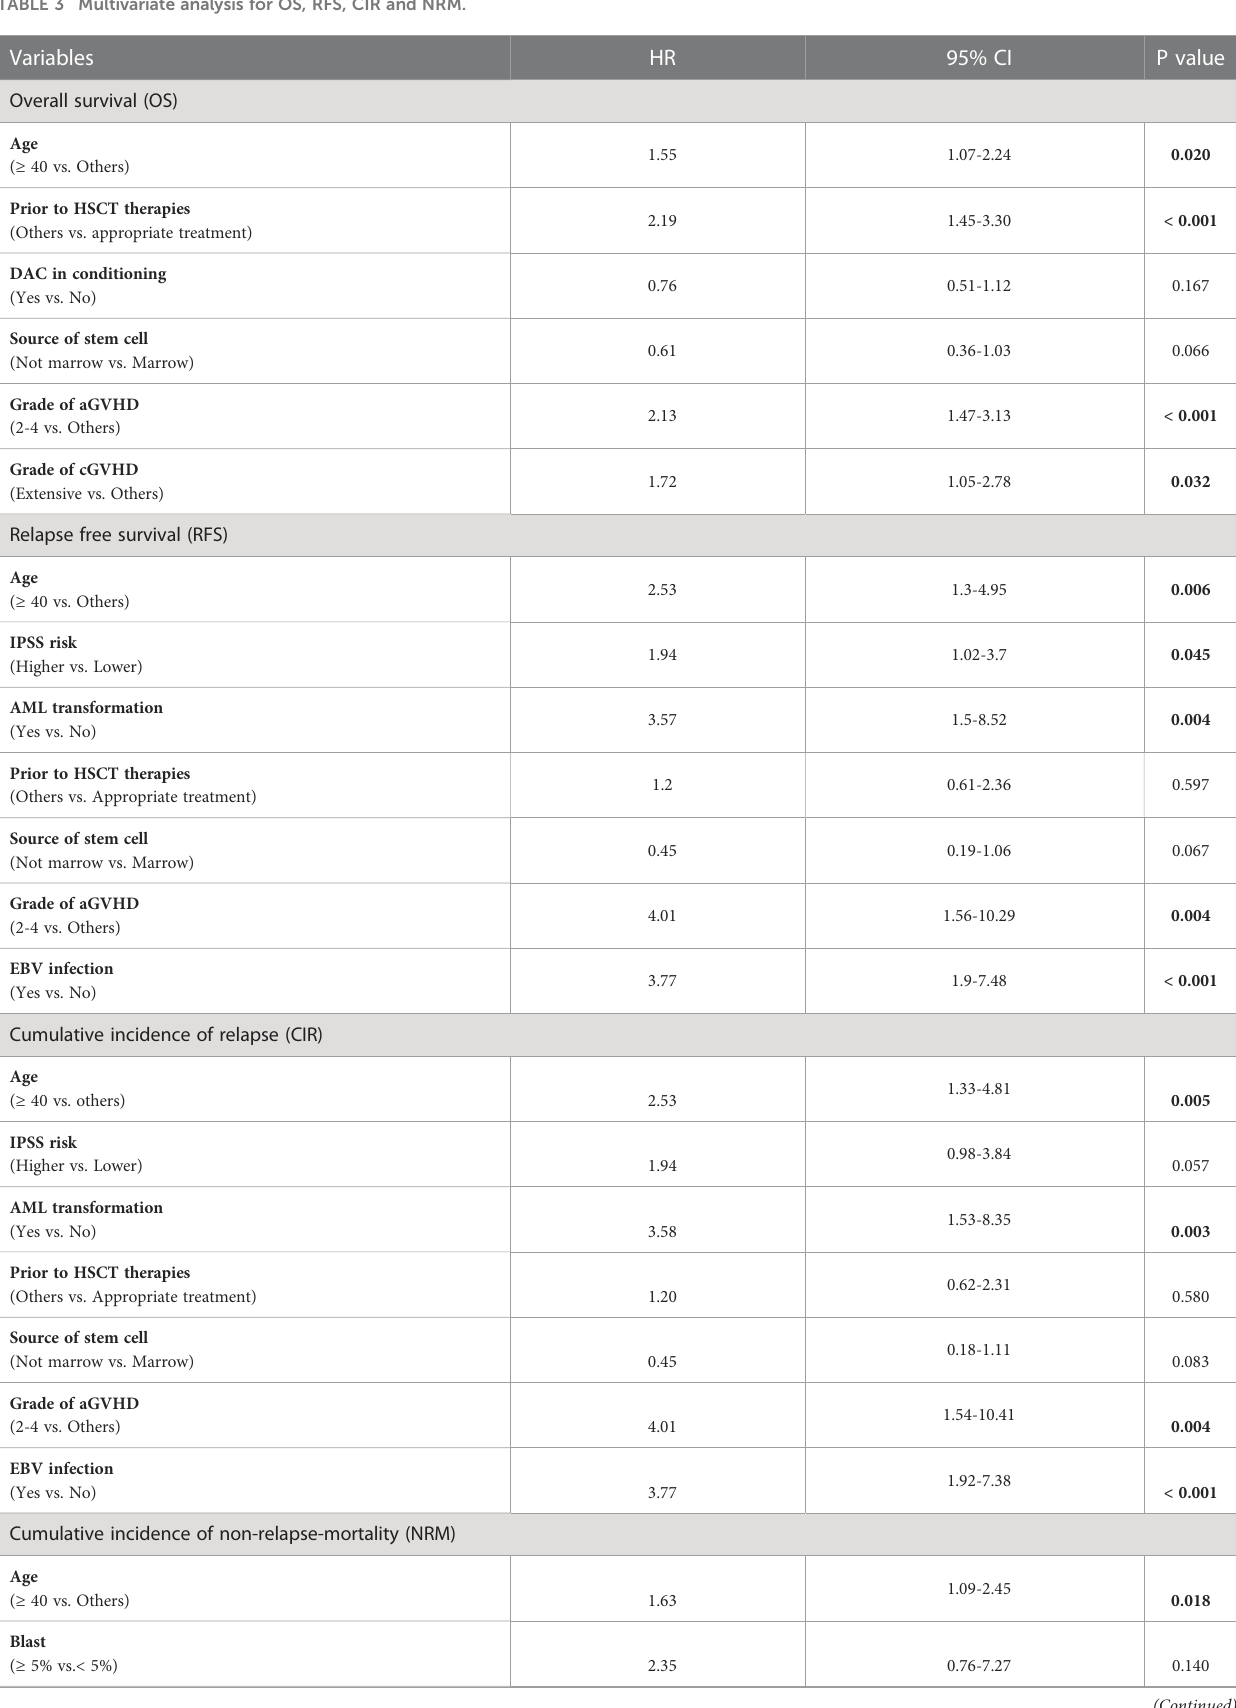
TABLE 3 Multivariate analysis for OS, RFS, CIR and NRM.